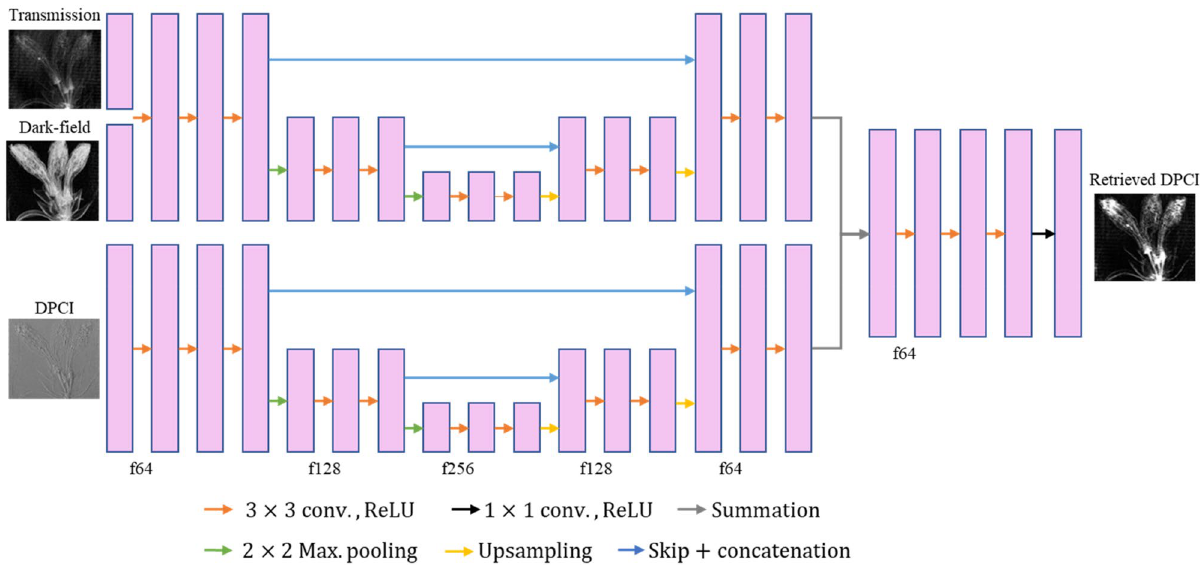
Figure 9. The network architecture used in this